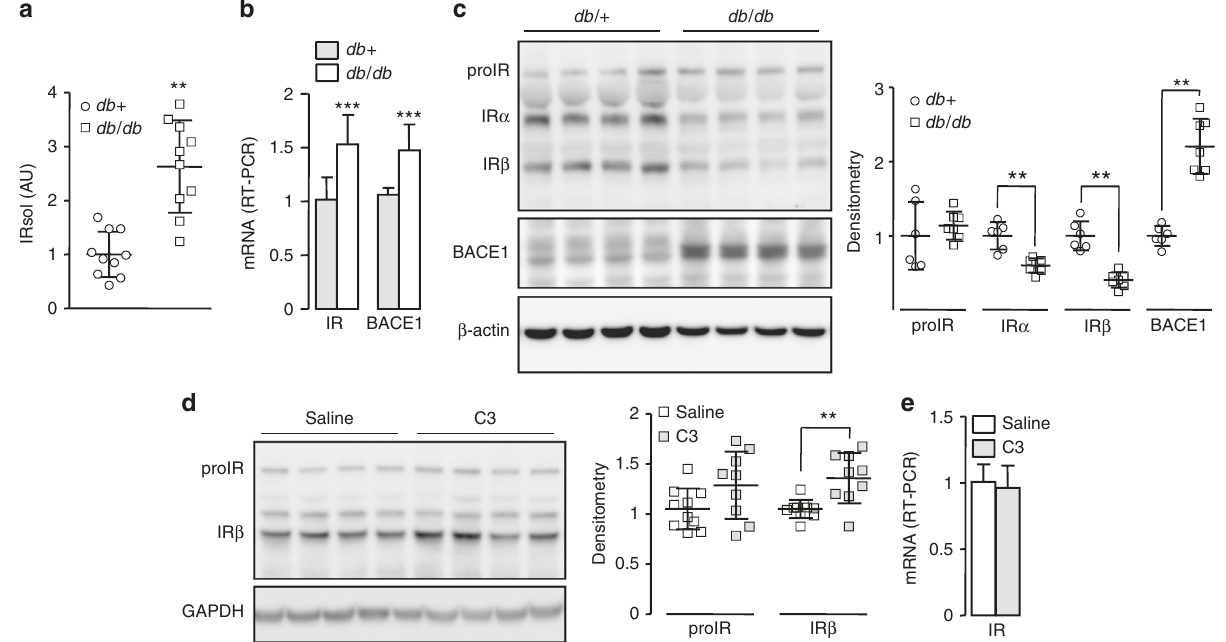
Fig. 8 IR cleavage in a mouse model of diabetes. a IRsol was measured in the plasma from db/db mice ( n = 10) and from their control littermate ( db/ + ; n = 10). b mRNA levels of IR and BACE1 were measured by RT-PCR in the liver. c Liver expression of IR, BACE1, and β -actin (loading control) were analyzed by immunoblot; a densitometric analysis of the proIR, IR α , IR β , and BACE1 bands was performed (right), values are expressed as fold over the means of the wild-type mice. d db/db mice were treated with saline or with BACE1 inhibitor (C3, 4 weeks), then liver expression of IR and GAPDH (loading control) were analyzed by immunoblot; a densitometric analysis of the proIR and IR β bands was performed (right). e mRNA levels of IR were measured by RT-PCR in the liver of db/db mice treated with saline or with the BACE1 inhibitor (C3). Data are means ± s.d. Statistical analyses were made using unpaired t -test. ** p < 0.01; *** p < Furthermore, reducing glucose concentration decreases the the O -GlcNacylation processes that reduce the amount of BACE1 amount of immature BACE1, while increasing the mature form in matured by proprotein convertases (without interfering with an O -GlcNacylation-dependent manner. Our interpretation is proprotein convertase activity), thereby increasing IR cleavage that immature BACE1 cleaves IR and that high glucose triggers (Supplementary Fig. 14). Identi fi cation of the O -GlcNacylation